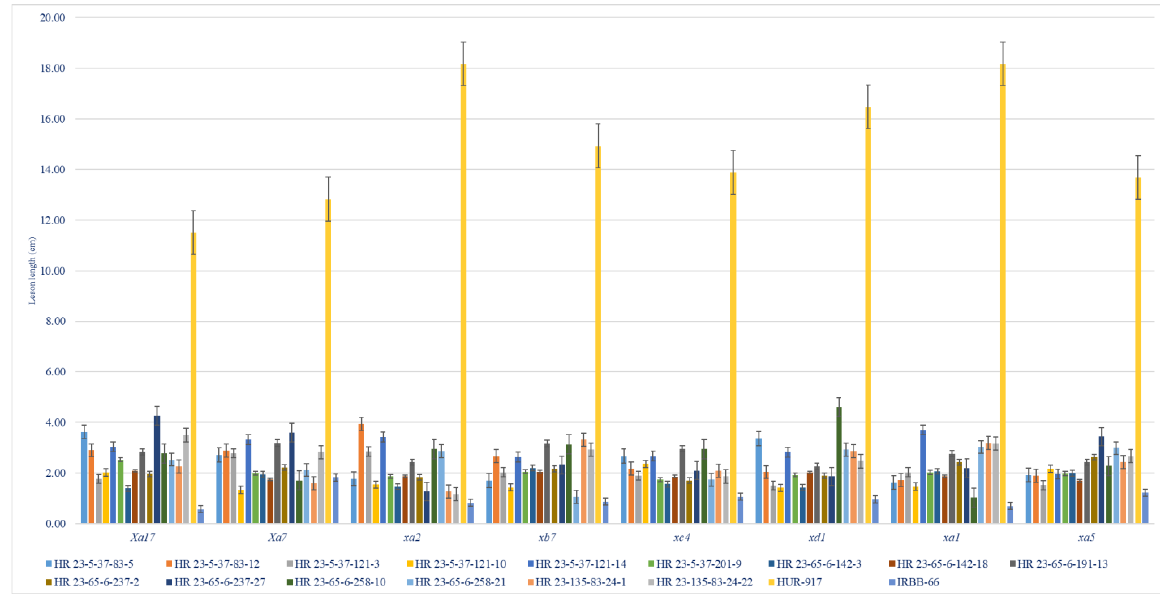
Figure 3. PCR amplification of bacterial blight resistant gene(s) in BC 2 F 2. ( a ) Amplicons of the Xa21 gene using pTA248 primer. ( b ) Amplicons of the xal3 gene using xal3 prom primer. ( c ) Amplicons of the xa5 gene using RM122 primer; M, marker; P1, RP (HUR 917); P2, donor parent (IRBB66), Lanes 4 – 18 represent NILs, vertical arrows indicate positive plant homozygous/heterozygous for targeted genes .